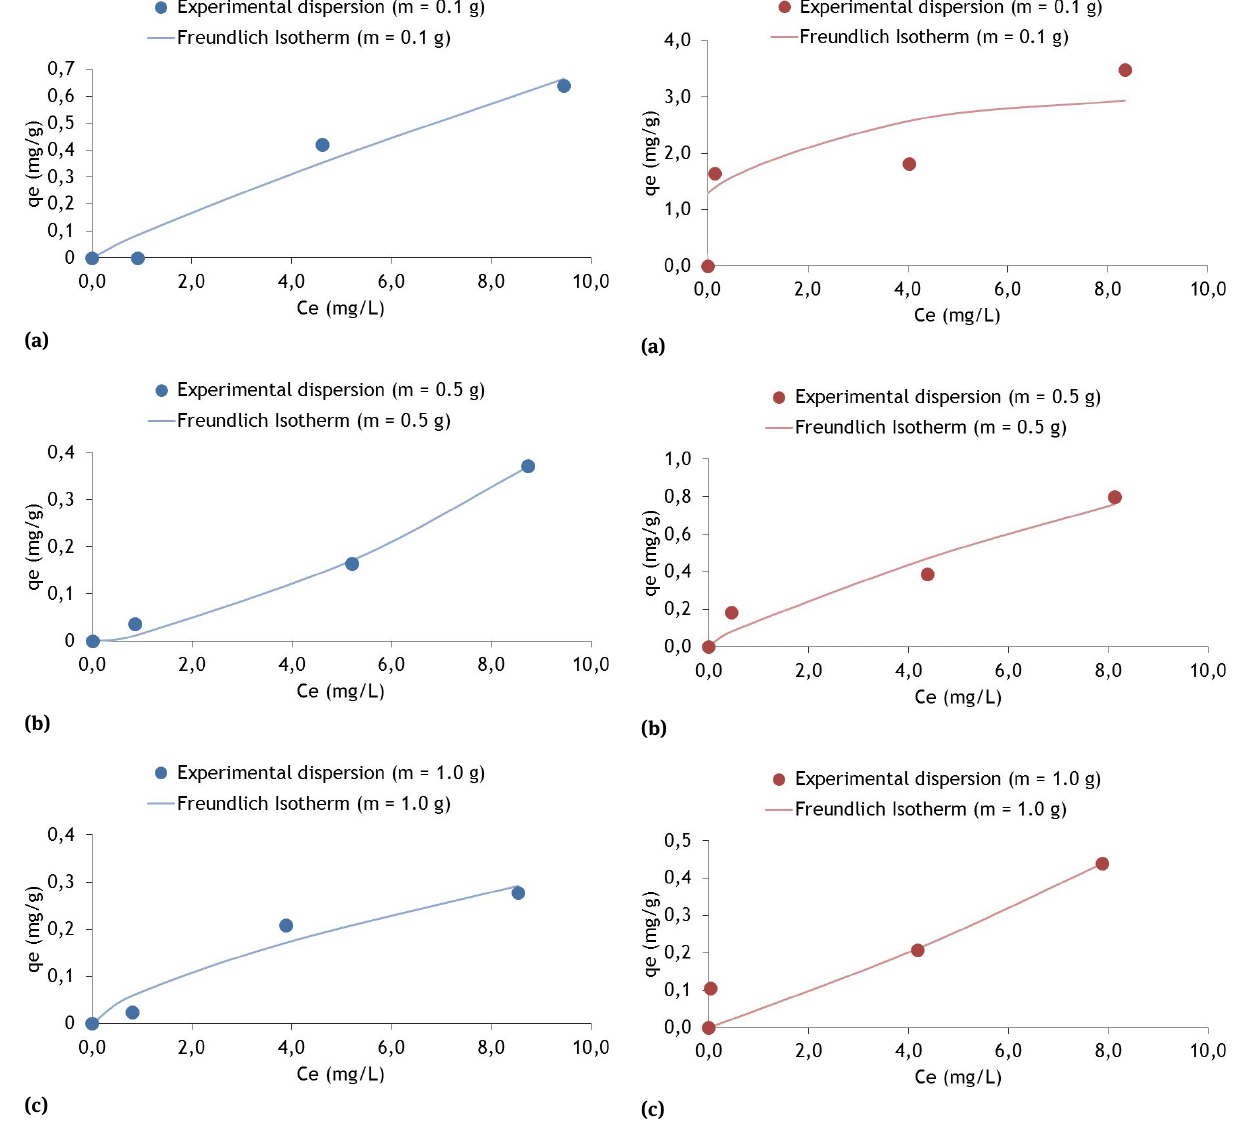
mg Zn/g for C of 8 mg/L (for Ca-B and Na-B soils) and from e 6 mg Zn/g to 8 mg/L in the case of crude kaolin.